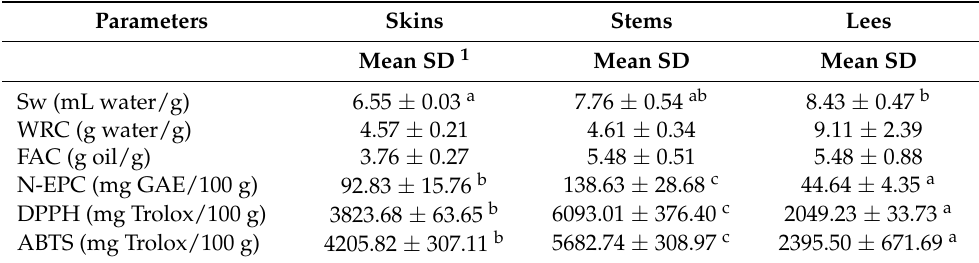
Table 3. Functional properties and non-extractable phenolic compounds (N-EPC) of dietary fibre from skins, stems and